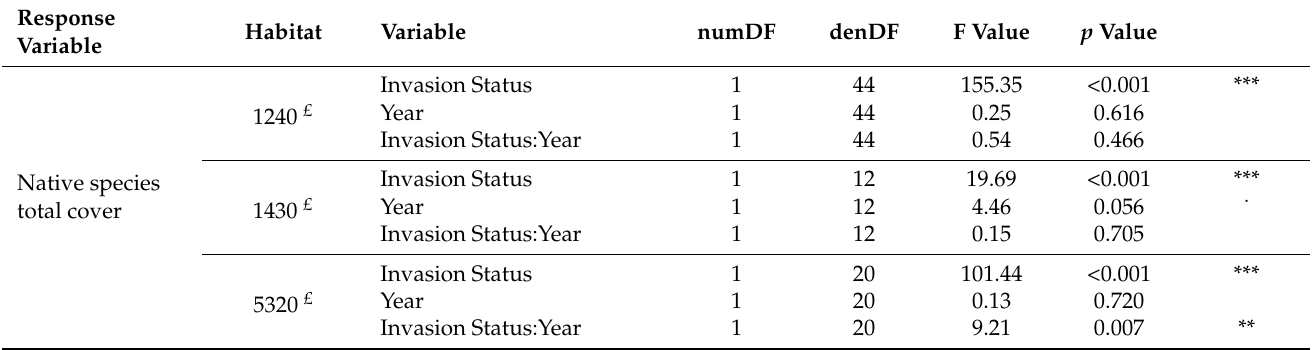
Table 1. Repeated Measurement ANOVA table for the effect of Invasion Status (Control plots vs. Invaded plots) and Year (sampling year 2020 vs. 2021) on Native species total cover, native species richness and native species diversity expressed as H’, provided for each Natura 2000 habitat. N2000 habitat codes: 1240 = vegetated sea cliffs of the Mediterranean coasts with endemic Limonium spp., 1430 = Halo-nitrophilous scrubs ( Pegano-Salsoletea ) and 5320 = Low formations of Euphorbia close to cliffs. numDF: numerator degree of freedom; denDF: denominator degree of freedom.